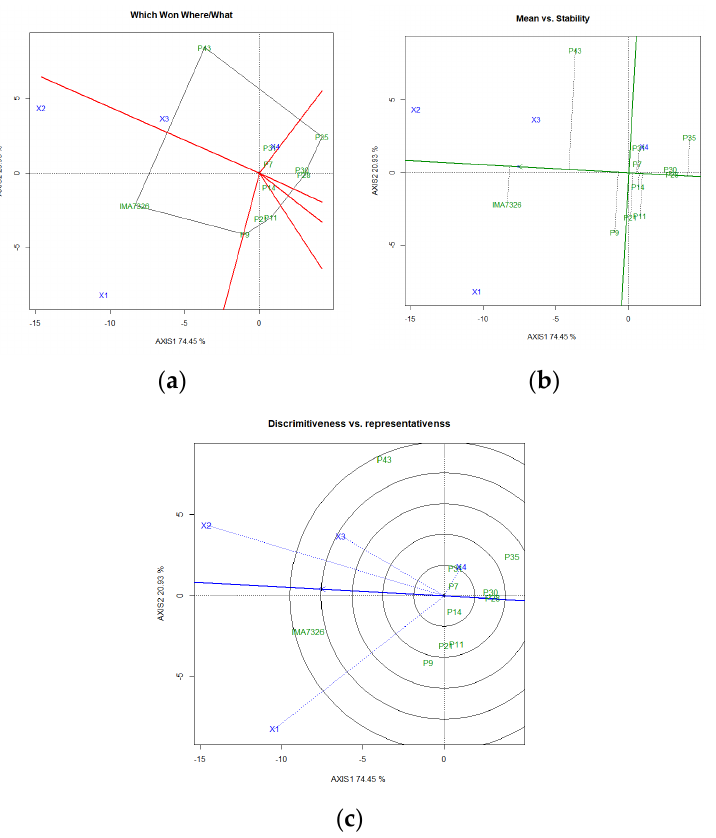
Figure 2. Polygon ( a ), stability ( b ), and ideal environment ( c ) tested for oil content obtained by the GGE biplot method in safflower genotypes grown in four environments of the Brazilian Cerrado. Environments: X1: Bauru-SP; X2: Botucatu-SP(1); X3: Botucatu-SP(2); X4: Campo Novo do Parecis-MT.